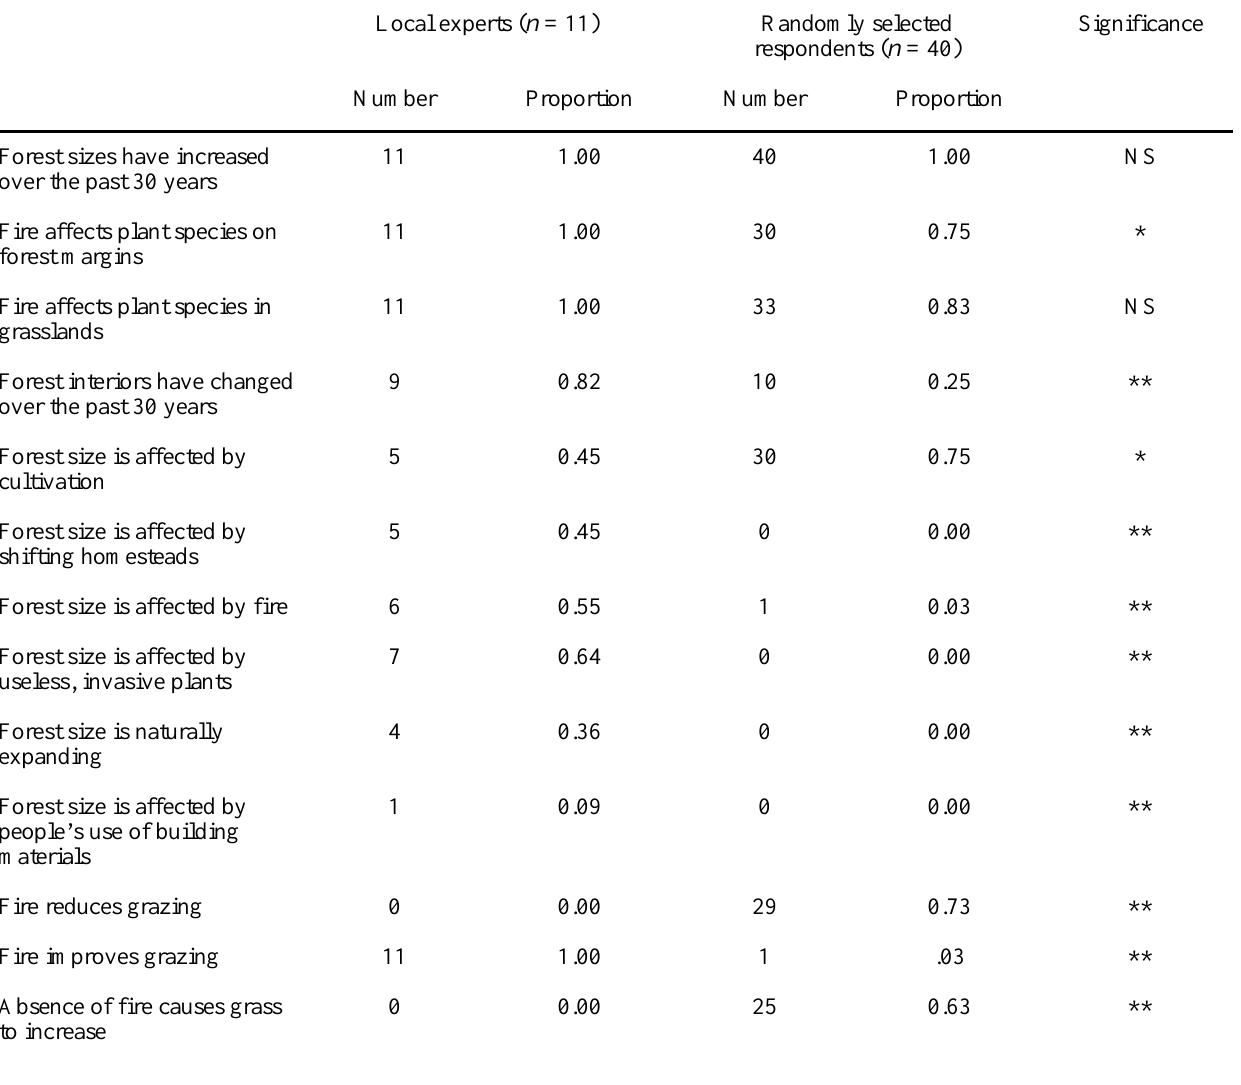
Table 3. A comparison between the beliefs of local experts ( n = 11) and local generalists ( n = 40) about the causes of land-cover change at